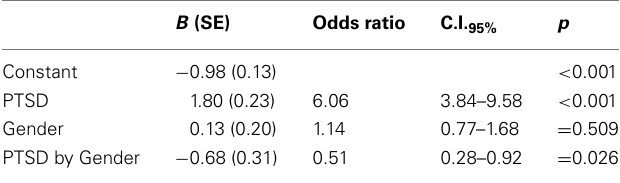
Table 2 | Binary logistic regression analysis (PTSD and gender as predictors of at least one maladaptive behavior) applied to 372 L’Aquila earthquake survivors with